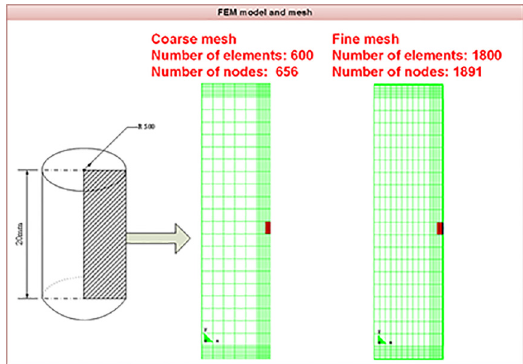
Figure 8. Schematic of coarse and fine FEM mesh.